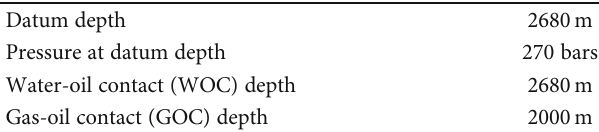
Table 2: Equilibrium data properties.